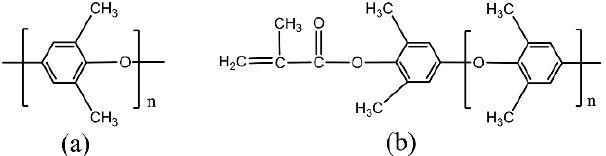
Figure 1. Chemical structures of ( a ) polyphenylene ether (PPE) and ( b ) modified PPE (MPPE).